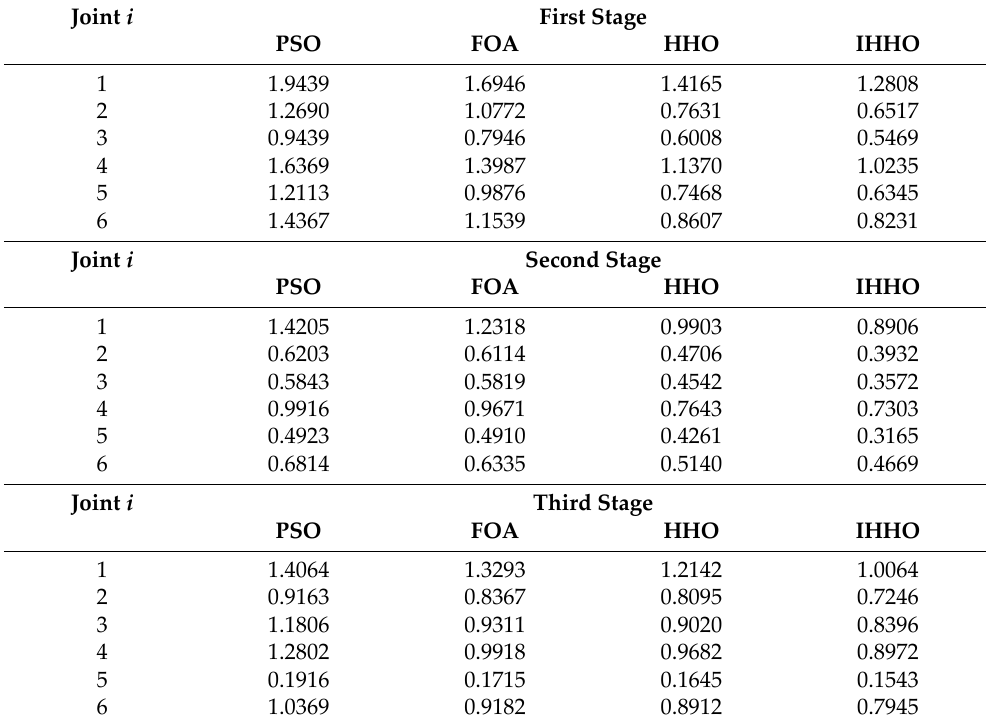
Table 5. The optimal interpolation time of each segment of each joint (s).